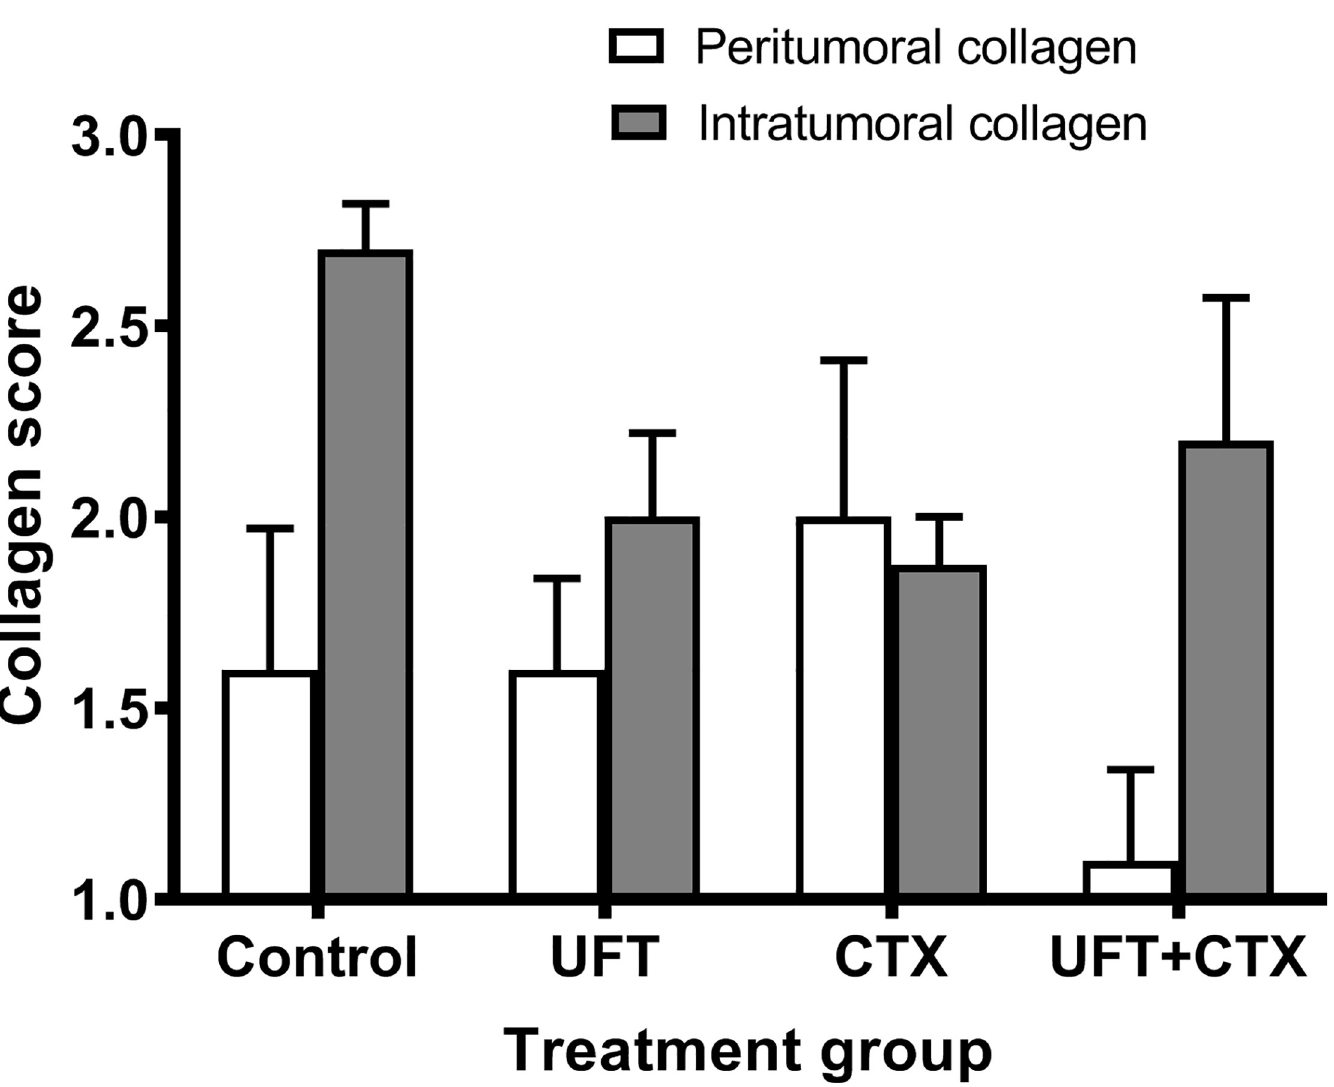
Fig 4. Assessment of peritumoral and intratumoral collagen deposition in paraffin tumor sections. The collagen content of the tumors was analyzed by Masson´s trichrome histochemical staining in control and treated groups. A grading system composed of mild/focal (grade 1), moderated (grade 2) and extensive (grade 3) collagen deposition was used. The columns represent the mean ± standard error of the mean (SEM), of the score values corresponding to peritumoral collagen (white) and intratumoral collagen (grey) of the tumor sections corresponding to each treatment group. The statistically analysis by One-Way ANOVA shows no statistical significant difference between groups. (One-Way ANOVA, Dunnett’s multiple comparison test P >